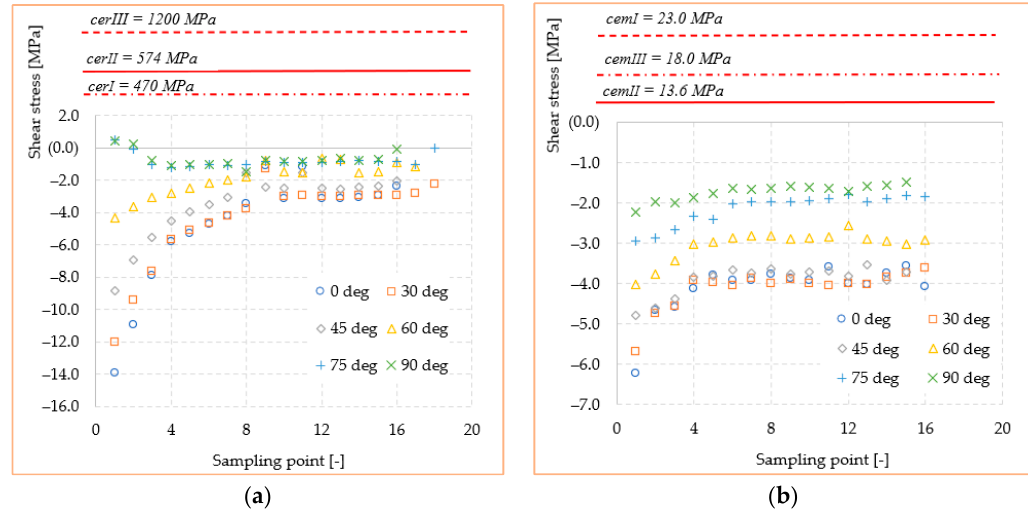
Figure 11. Mechanical strength of dental materials and shear stresses recorded at interface: ( a ) ceramic; ( b ) adhesive cement.